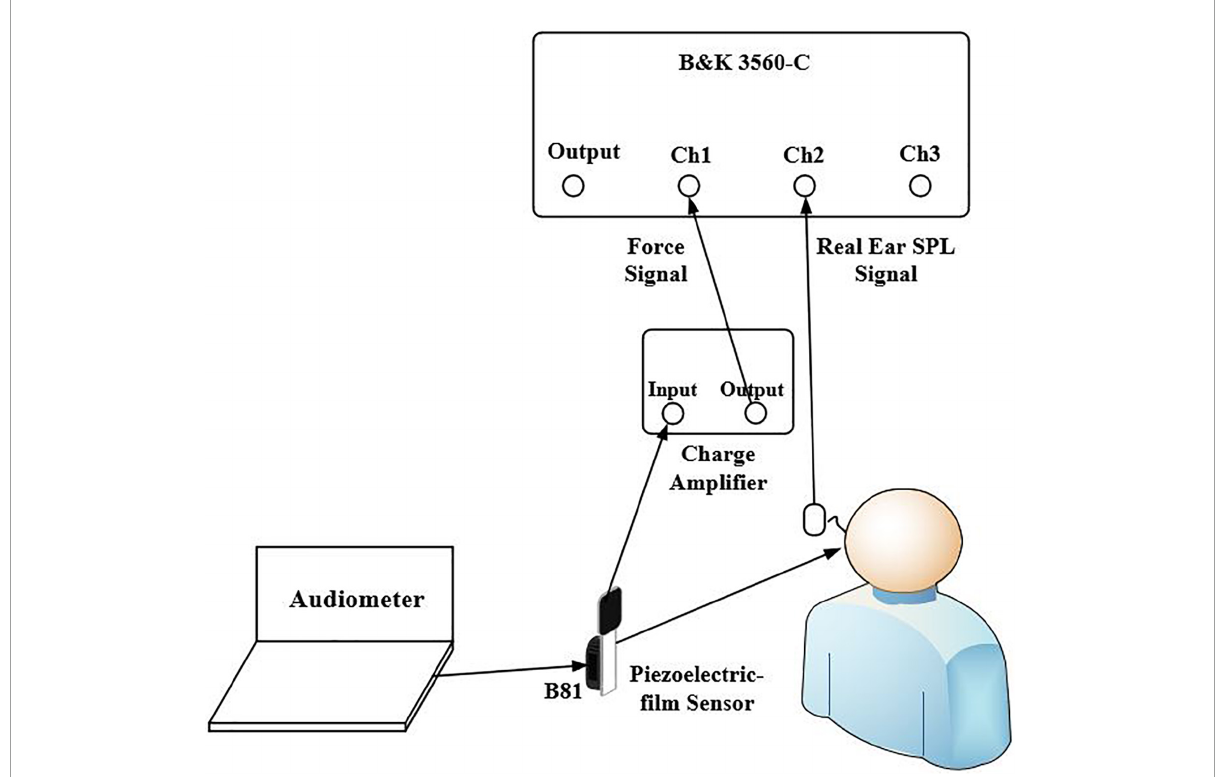
FIGURE1 The experimental setup to determine the HL-to-SPL transform and the HL-to-FL (force transducer) transform. The B81 transducer was connected to the audiometer to output a signal at 30 dB HL per frequency. The probe microphone was placed in the ear canal for the SPL measurements and the force transducer was placed tightly between the B81 transducer and the stimulation position for the FL_FT